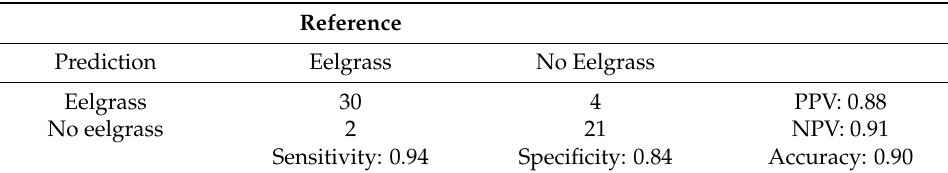
Table 2. Confusion matrix for the assessment of UAV-derived seagrass cover classification accuracy. Reference data were obtained using geolocated quadrats in the field.